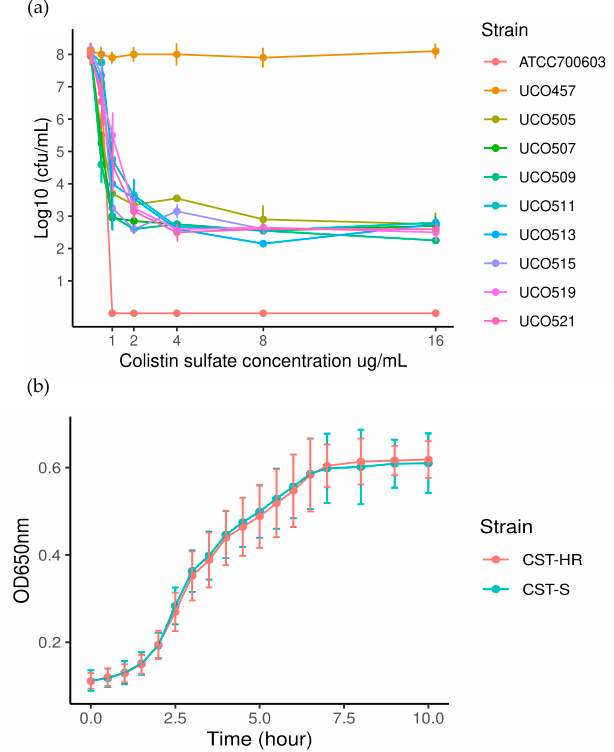
Figure 1. ( a ) . Population analysis profiles (PAPs) for CST-HR strains. ATCC 700603 ( Klebsiella quasipneumoniae subsp. similipneumoniae ) was used as a negative control (CST-susceptible) and E. coli UCO457 as a positive control (CST-resistant mcr-1 positive); ( b ) . bacterial growth curves for CST-susceptible (CST-S) and heteroresistant (CST-HR)